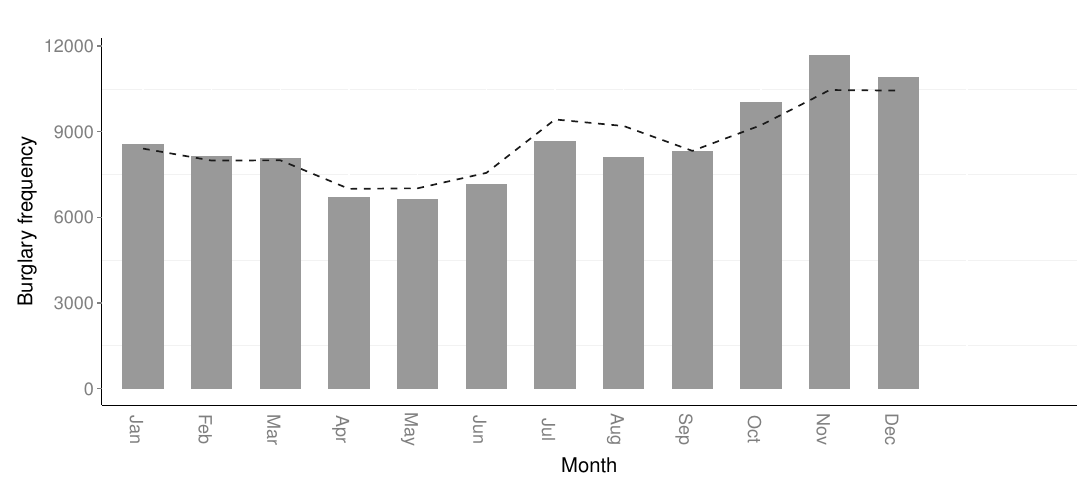
Figure 4. Aoristic distribution of all burglaries and attempted burglaries with a month resolution between 2010 and 2014 with the baseline shown as a dashed line.